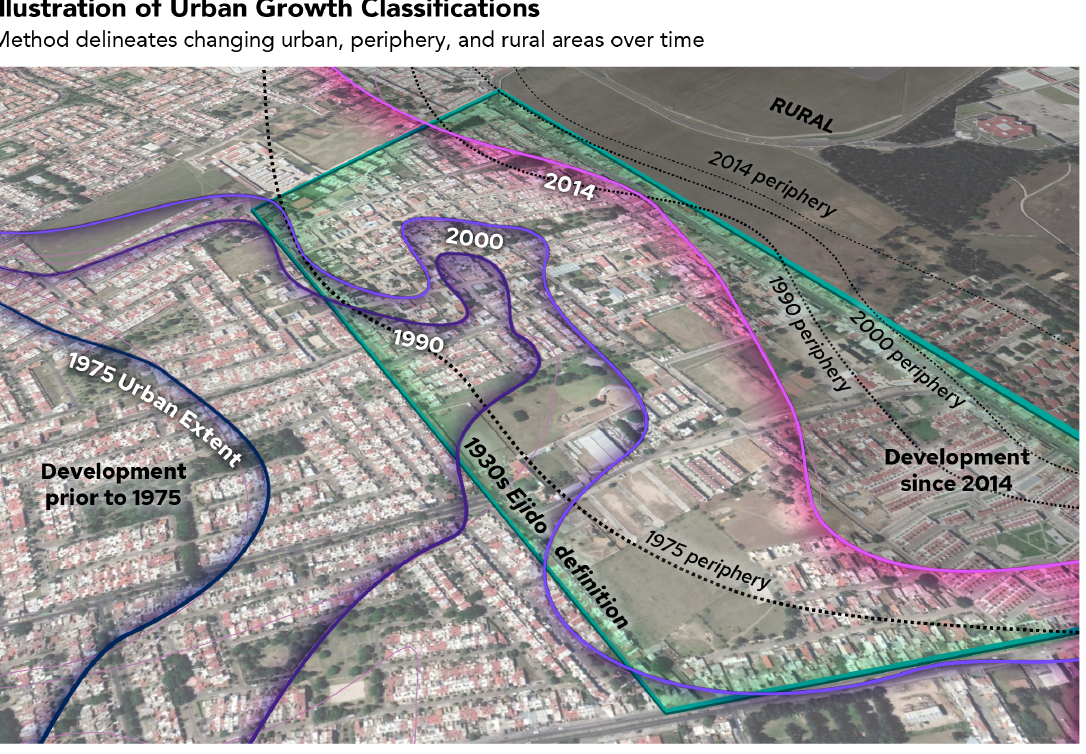
Figure 5. Urban extent over time—close